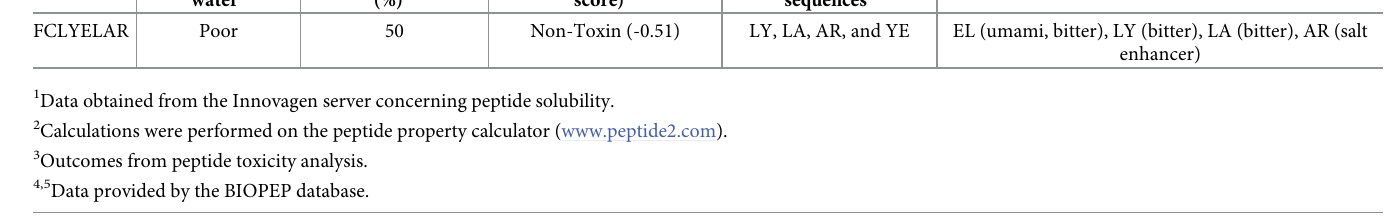
Table 7. The profiles for the properties of the FCLYELAR peptide.